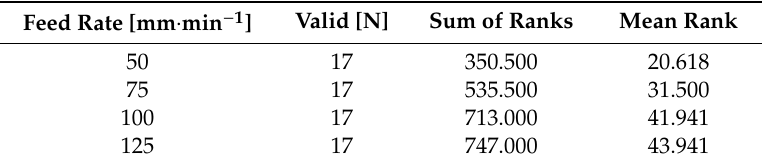
Table 11. Results of Kruskal–Wallis scattering analysis for cutting head feed